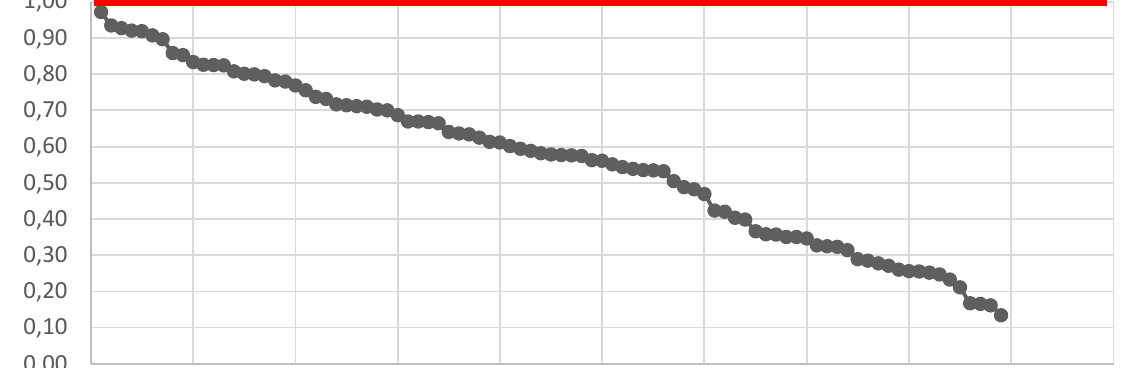
Figure 1. Output-oriented estimated technical efficiency